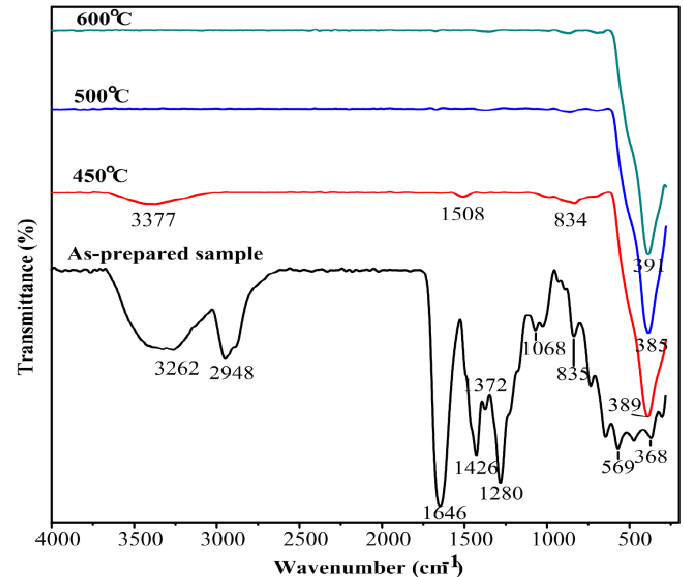
Figure 2. FT-IR spectra of as-prepared sample and ZnO nanoparticles at different calcination